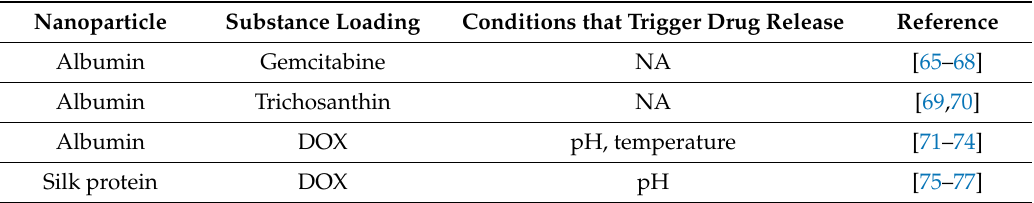
Table 2. Types of chemical reactions, substance loading, and conditions that trigger drug release of anti-cancer